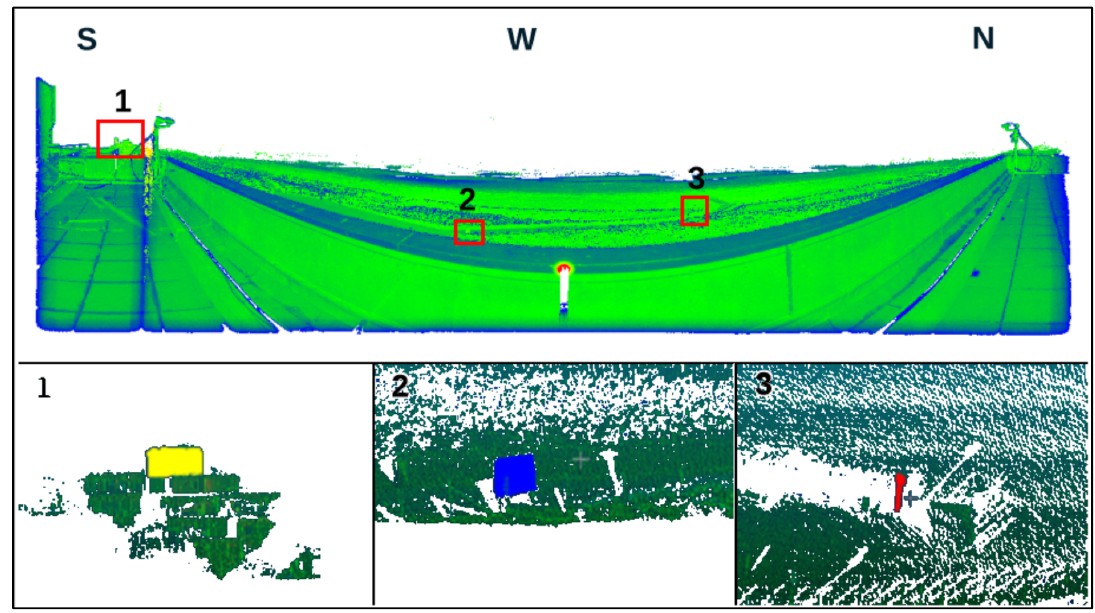
Figure 4 . ( Top image ) Spherical view of a Kijkduin point cloud (colored according to reflectance) with a south-west-north orientation. The edge of the roof can be seen in the foreground, while the observed part of the coast up to the water line is in the background. Low surface reflectance is indicated by blue colors while high surface reflectance is indicated by green colors; ( Bottom image ) Detailed images of the reference objects (see Figure 2 for the locations) in the surrounding of the building, to the south of the laser scanner ( 1 ), part of a neighboring building and to the West ( 2 ), information sign and north-west of the laser scanner ( 3 ), sign on a post (modified from Vos et al., 2020).